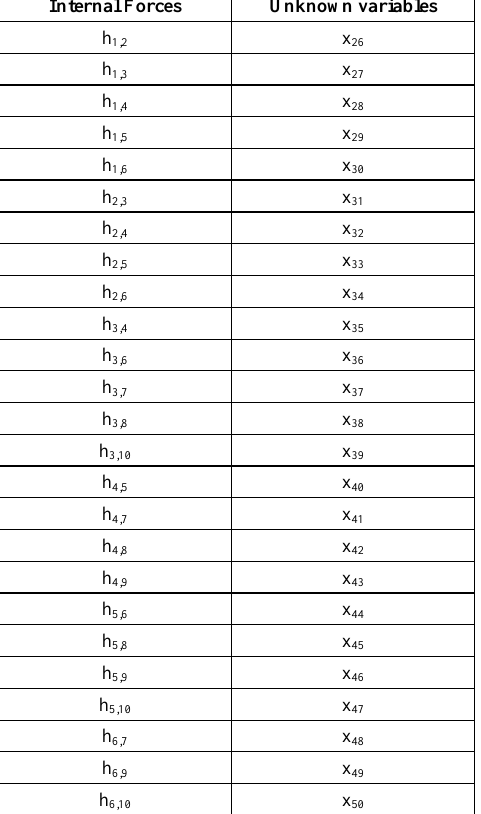
Table 6.Variables (x Internal Forces